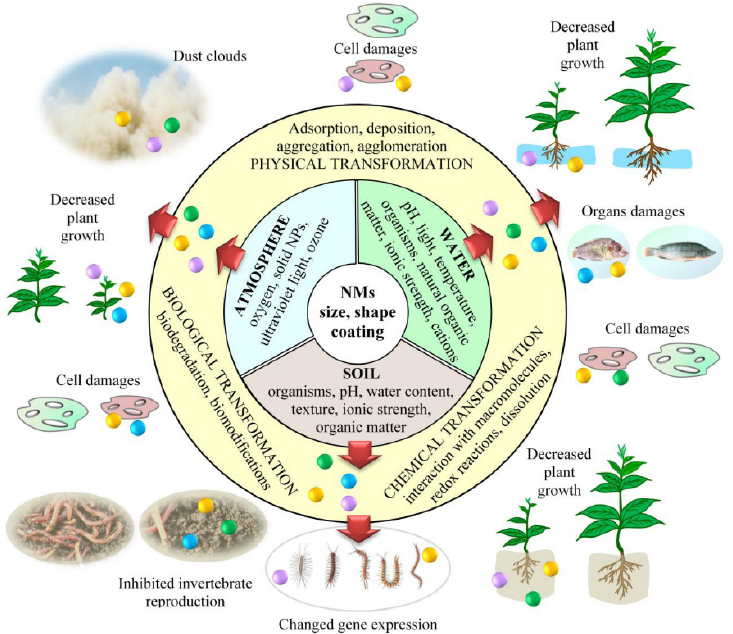
Figure 8. Toxicity and health impact of NPs. (Adapted with permission from Ref. [25]. Copyright © 2022 Elsevier.)